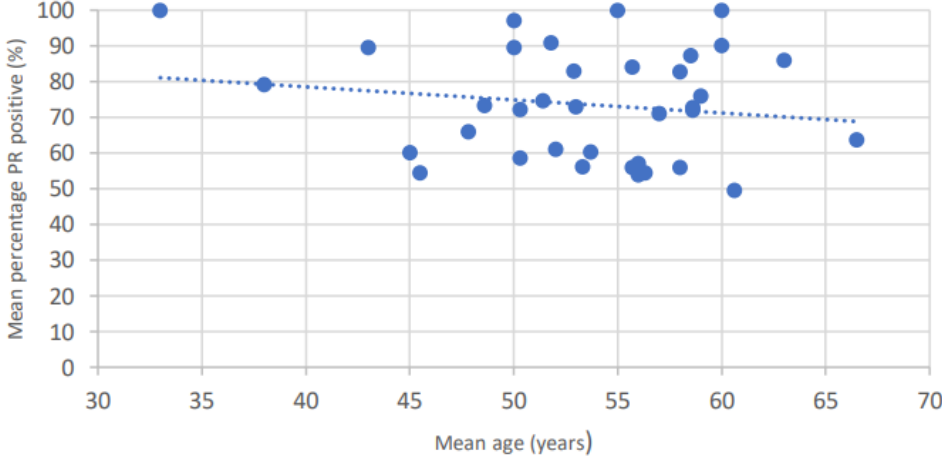
Figure 5. Age-dependent changes in progesterone receptors expression in meningiomas.